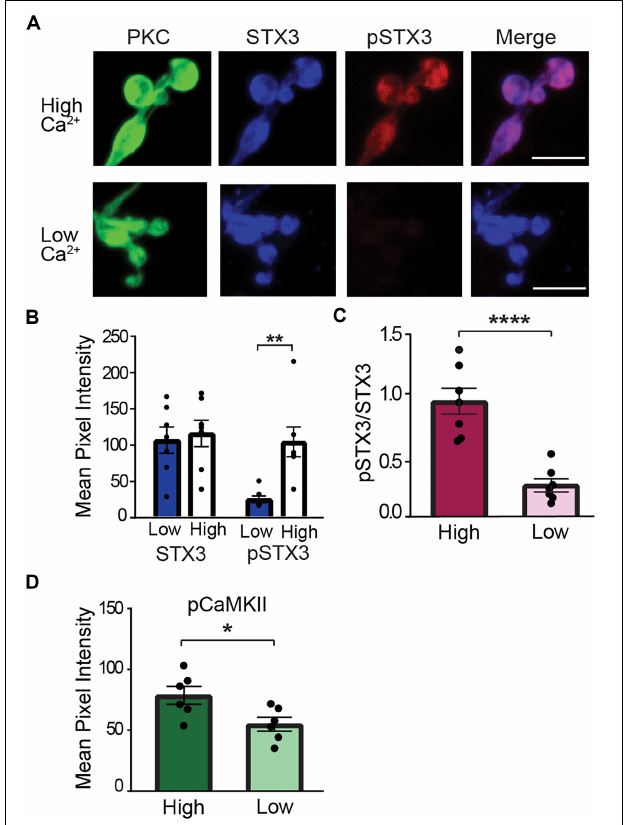
FIGURE 5 | Elevation of intraterminal Ca 2 + promotes phosphorylation of STX3B at T14 in rod bipolar cell synaptic terminals. (A) Confocal images of synaptic terminals of isolated rod bipolar cells, identified by their characteristic morphology and PKC immunoreactivity (green), demonstrate an increase in pSTX3 immunoreactivity (red) under conditions of elevated intraterminal Ca 2 + (“high Ca 2 + ,” top panel) when compared to those incubated on a nominally 0 Ca 2 + external solution (“low Ca 2 + ,” bottom panel). Scale bar = 5 µ m. (B) The mean pixel intensity of STX3 immunolabeling was not altered by changes in intraterminal Ca 2 + ( p = 0.7238). By contrast, elevation of intraterminal Ca 2 + led to an increase in pSTX3 immunolabeling ( p = 0.0077). (C) Quantification of the pSTX3/STX3 ratio in rod bipolar cell terminals indicates that elevated intraterminal Ca 2 + (“High”) significantly increased this ratio above that of cells bathed in nominally O Ca 2 + (“Low”). p < 0.0001. For (B,C) , n = 7,7 (mice). (D) Elevated intraterminal Ca 2 + (“High”) also increased CaMKII activation, as evidenced by an increase in pCaMKII immunolabeling in synaptic terminals of rod bipolar cells relative to terminals bathed in nominally 0 Ca 2 + external solution (“Low”). ( p = 0.0283; n = 6,6 mice). *Indicates p < 0.05, **indicates p < 0.01, and ***indicates p < 0.001.